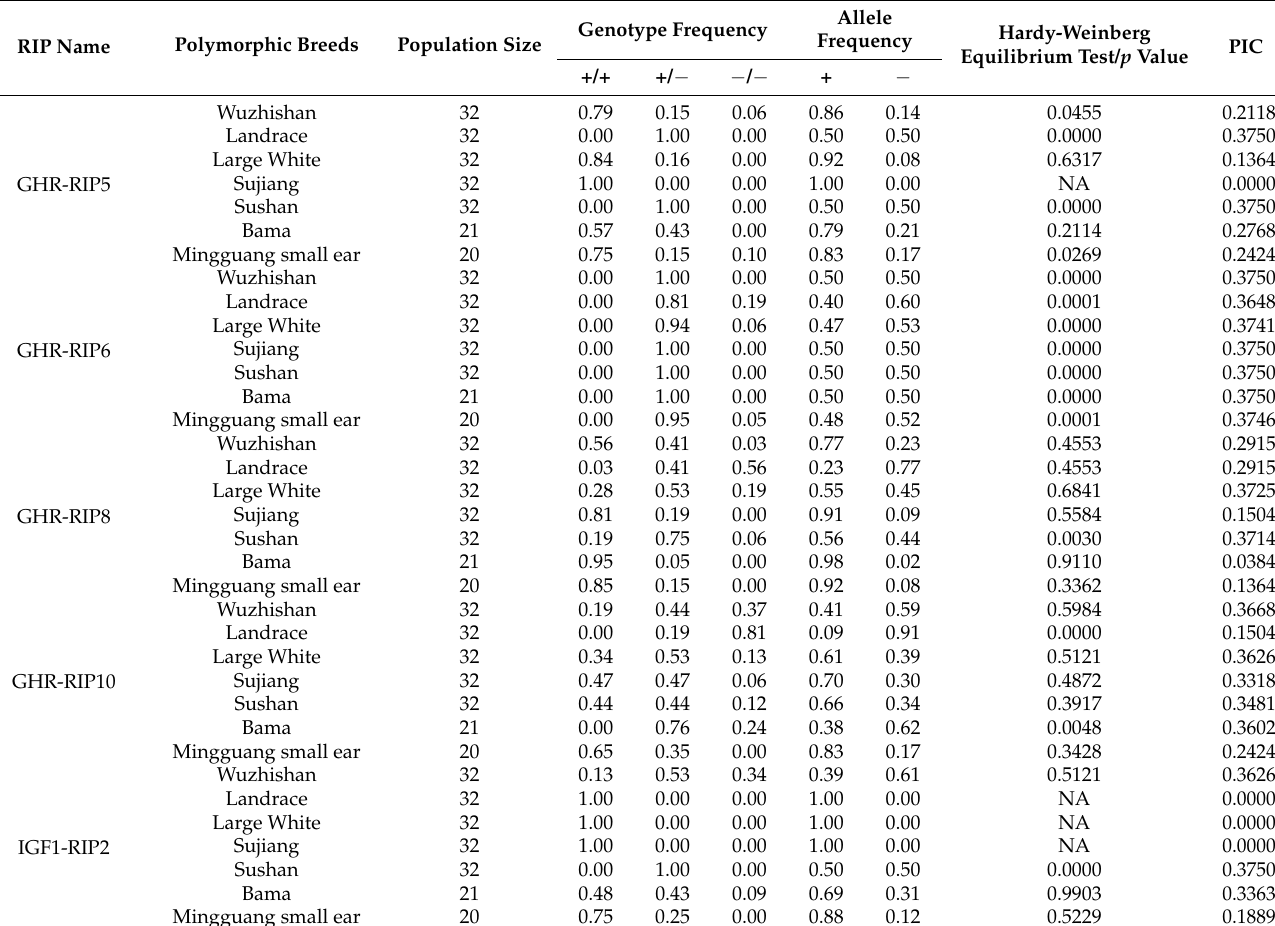
Table 3. RIP distribution in different pig